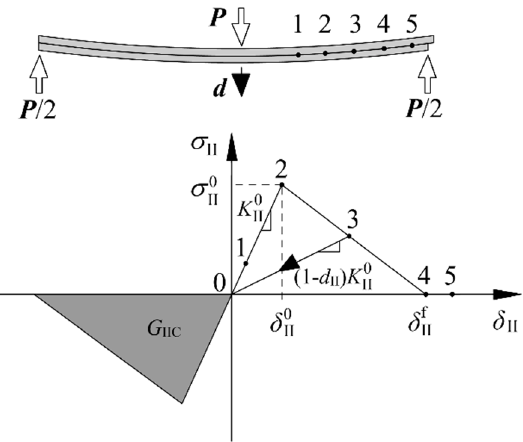
Figure 8. Bilinear constitutive law for the mode II delamination in an ENF specimen. K Interface stiffness 0 II